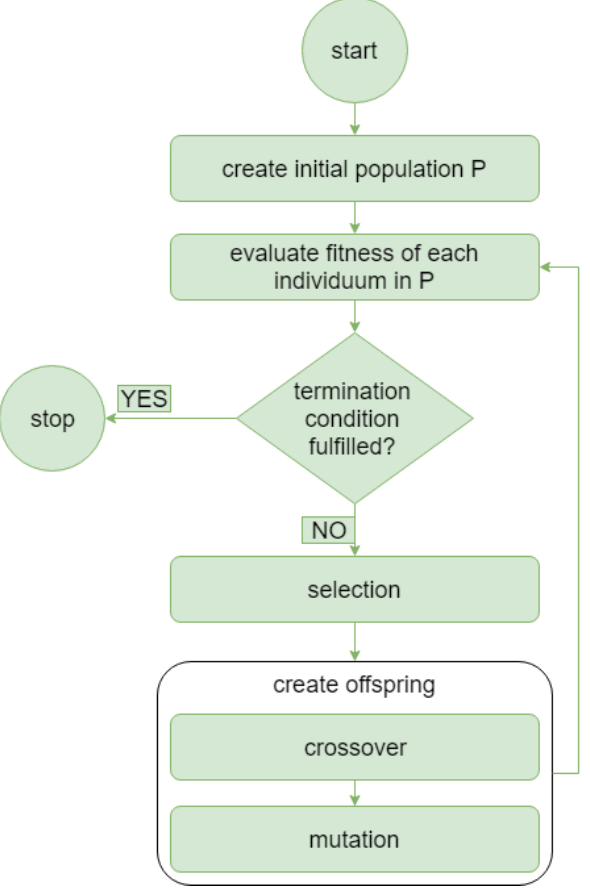
Figure 2. Genetic algorithm